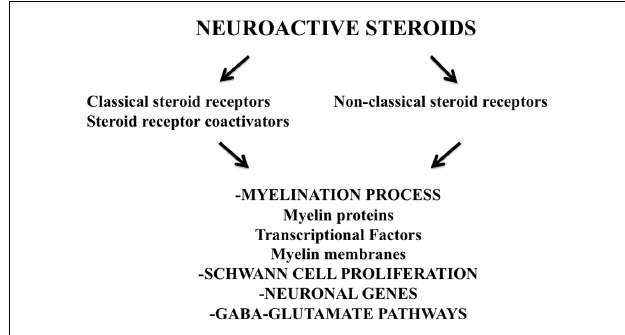
FIGURE 1 | Physiological effects of neuroactive steroids in peripheral